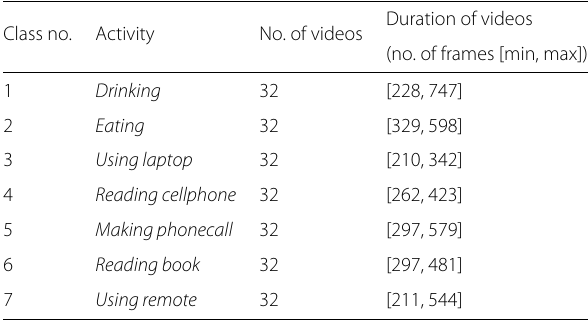
Table 2 Specifications on Dataset-B Class no.